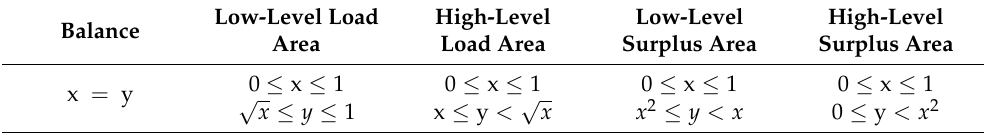
Table 2. Classification of RECC status.